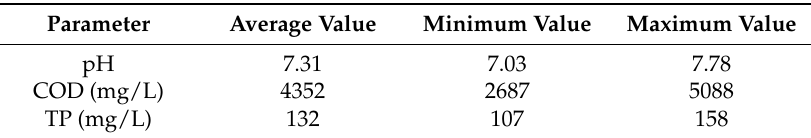
Table 1. Characteristics of the digestate